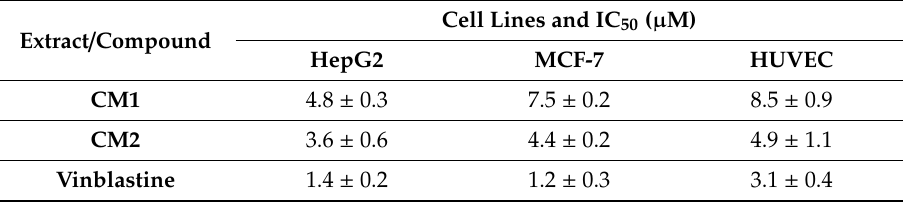
Figure 2. Cytotoxic e ff ects of compounds CM1 and CM2 on di ff erent human cell lines. The viability was measured by an MTT assay. Cells were cultured as described in the methods and treated with various concentrations of CM1 and CM2 (1–40 µ M) for 48 h. The Student’s t-test was used to calculate the statistical di ff erences. The data are presented as the mean ± S.D. (* p < 0.05, ** p < 0.01, and *** p < 0.001 were considered significant compared to the control) for the three independent experiments carried out in triplicate. Table 1. Comparison of the IC 50 values of the chloroform extract and fractionated compounds against MCF-7, HepG2, and human umbilical vein endothelial cells (HUVEC) cell lines. Extract /